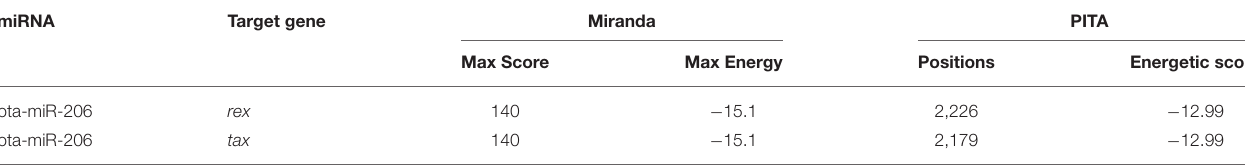
TABLE 4 | BLV genes targeted by bta-miR-206.